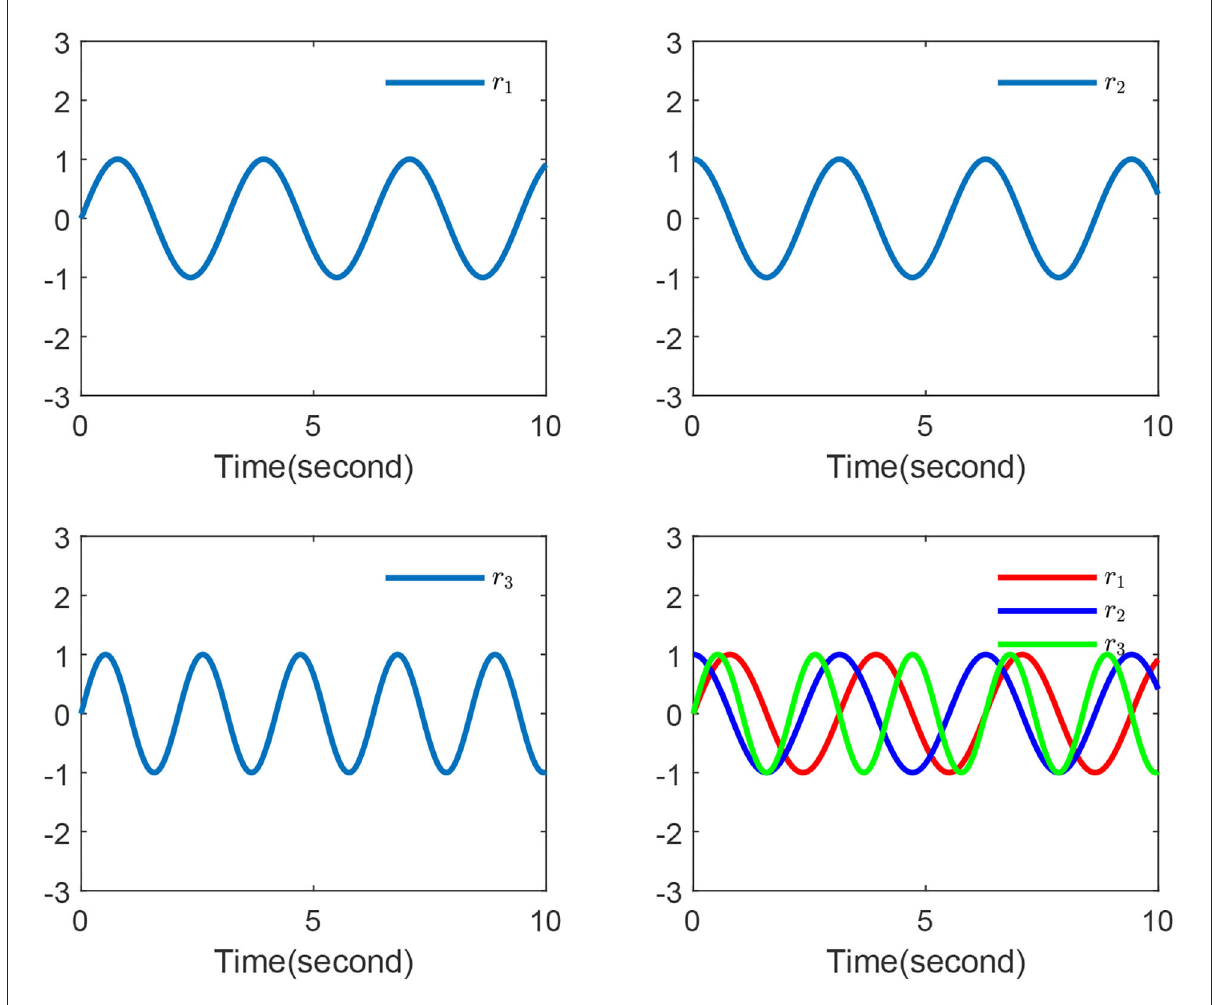
FIGURE3 External